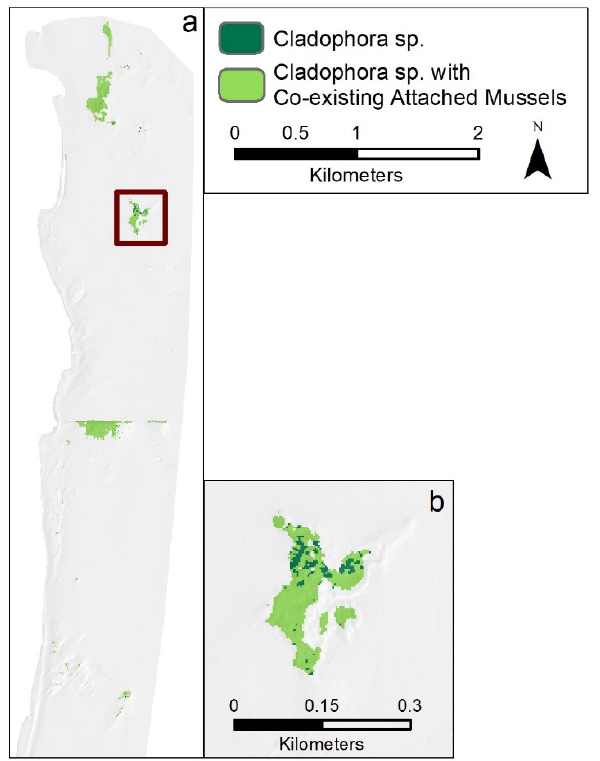
Figure 20. Tier 2 aquatic vegetation bed (biotic) classification results using airborne data combinations for the north-central section of the study area: ( a ) AB DE + CA MNF FU + CA MNF WLR, CA MNF FU + CA MNF WLR, and AB RF + AB DE + CA MNF FU + CA MNF WLR) and ( b ) inset panel corresponding to box in panel a.